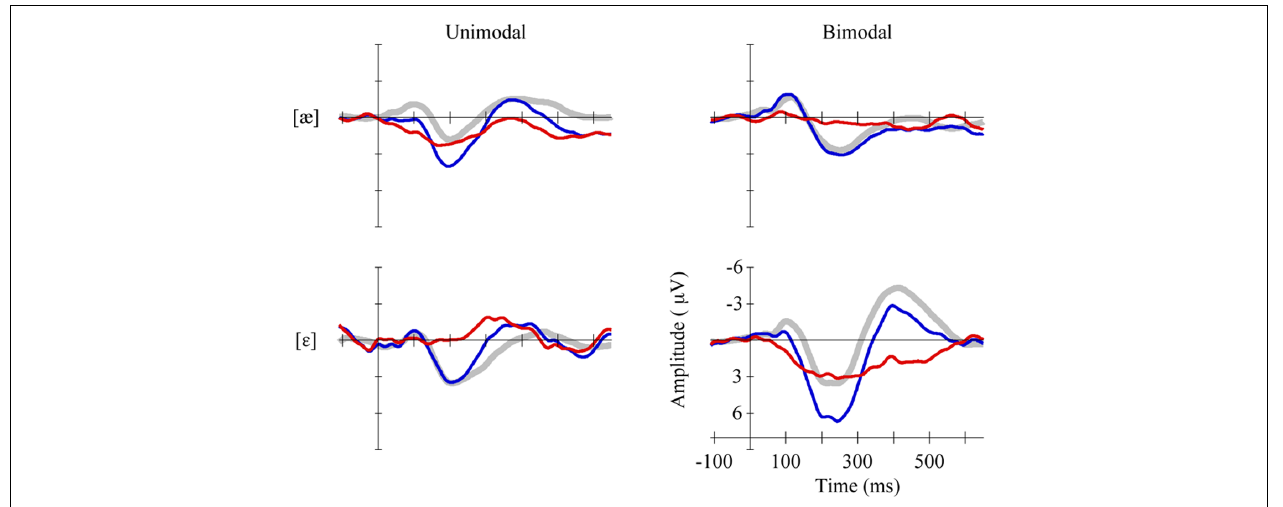
FIGURE 3 | Standards (gray, thick curves), deviants (blue, thin curves) and MMRs (red, thin curves) in non-QS, pooled across eight electrodes, per group (Unimodal [ æ ] top left vs. Bimodal [ æ ] top right, Unimodal [ ε ] bottom left vs. Bimodal [ ε ] bottom right).